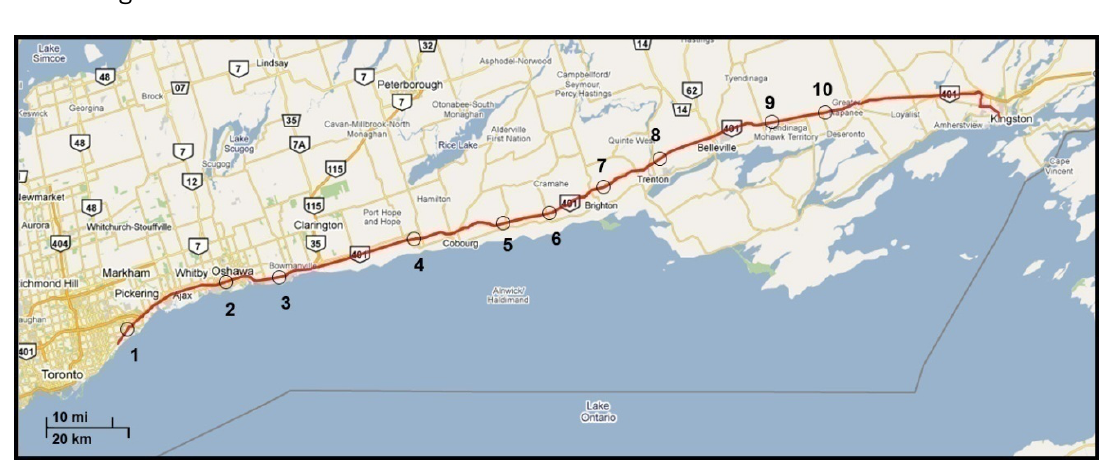
Figure 11. Road test trajectory from Toronto to Kingston. Circles indicate the locations of GPS